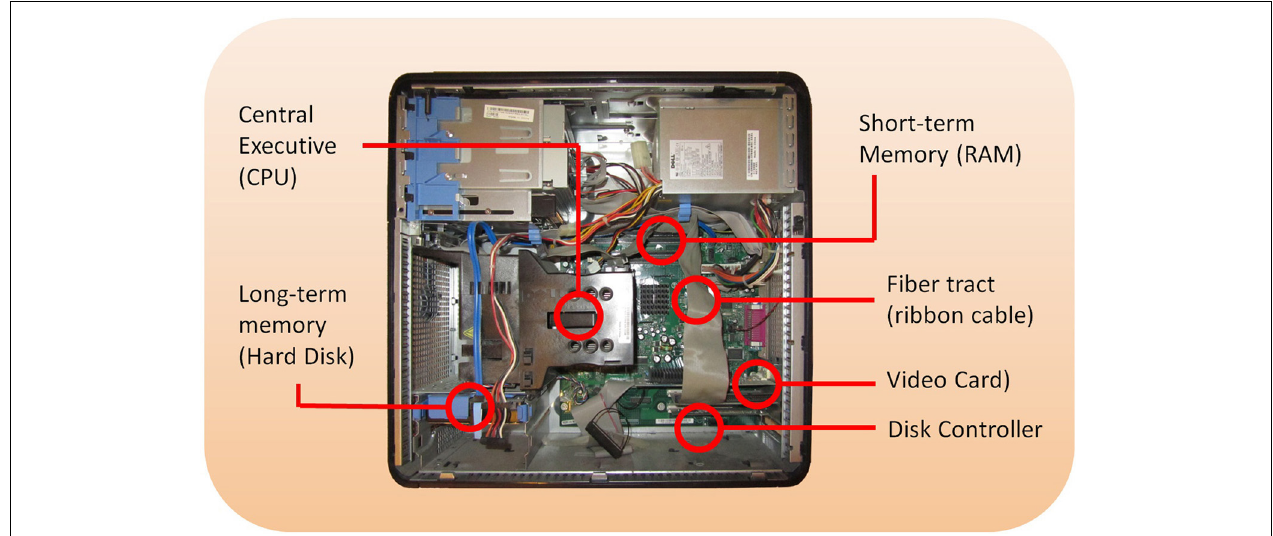
FIGURE 1 | The inside of a typical computer, showing CPU, hard disk, memory, and disk